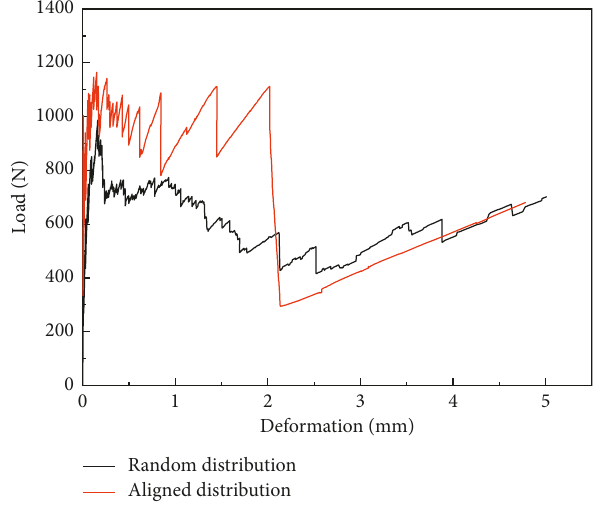
Figure 11: The simulated load-deformation curves for UHPFRC with different fiber orientation.